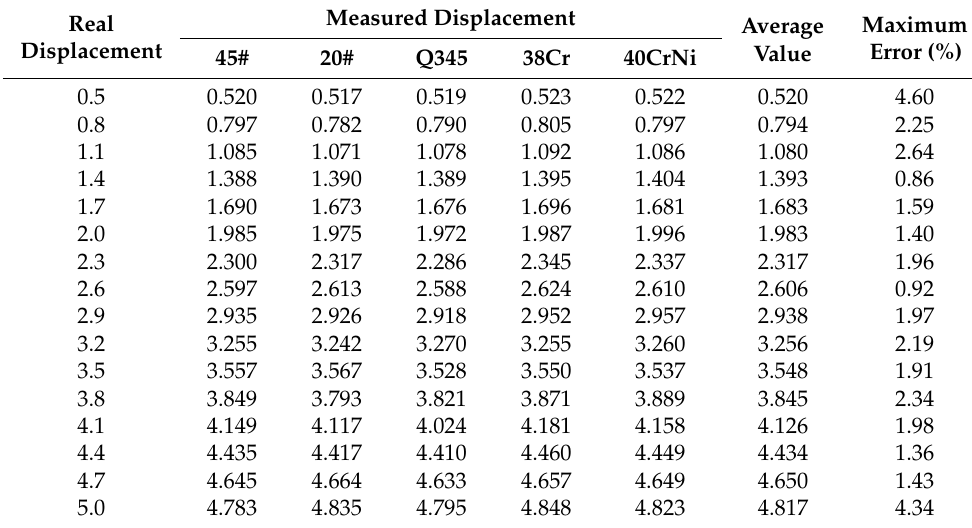
Table 5. Displacement measurement for different